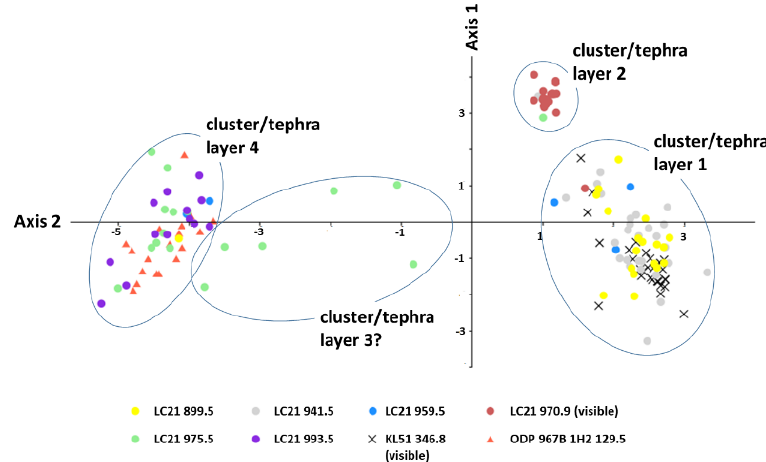
Figure 6. The 1st and 2nd canonical axes for linear discriminant function analysis (DFA) using EPMA